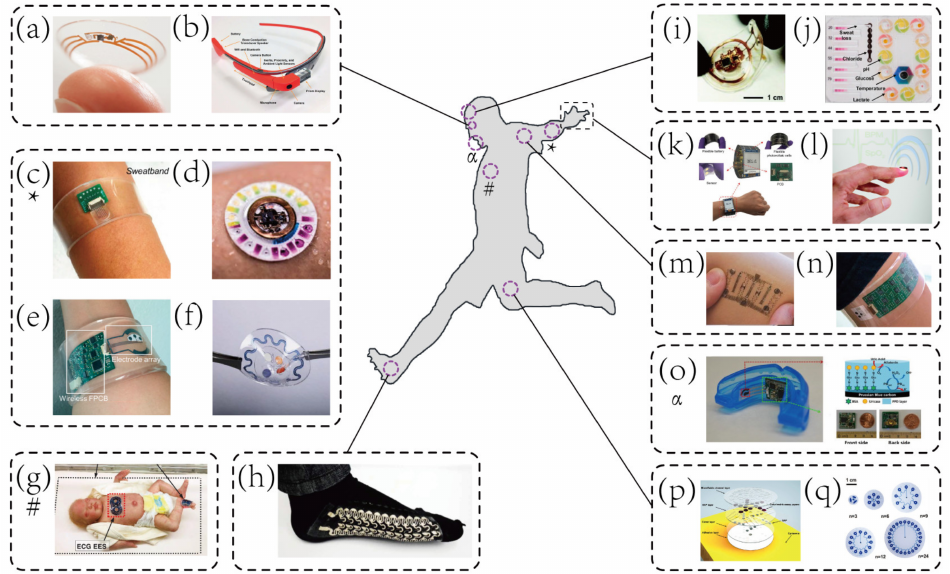
Figure 1. Representative examples of wearable biosensors for both healthcare and sports